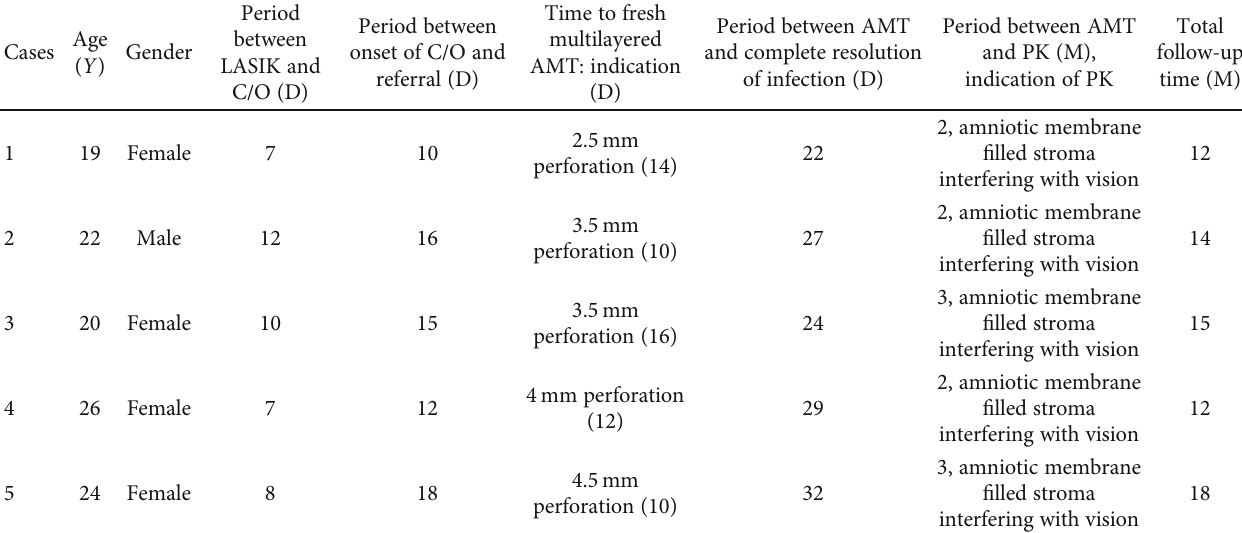
Table 1: Clinical characteristics of